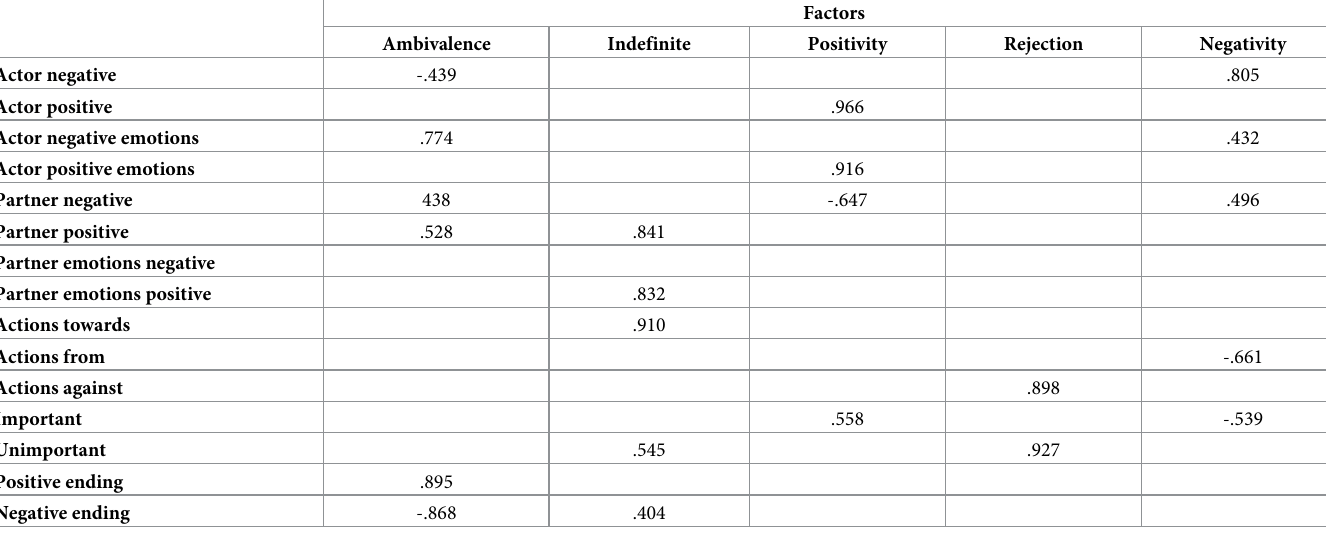
Table 3. Love: Exploratory factor analysis for narratives indicators ( n =